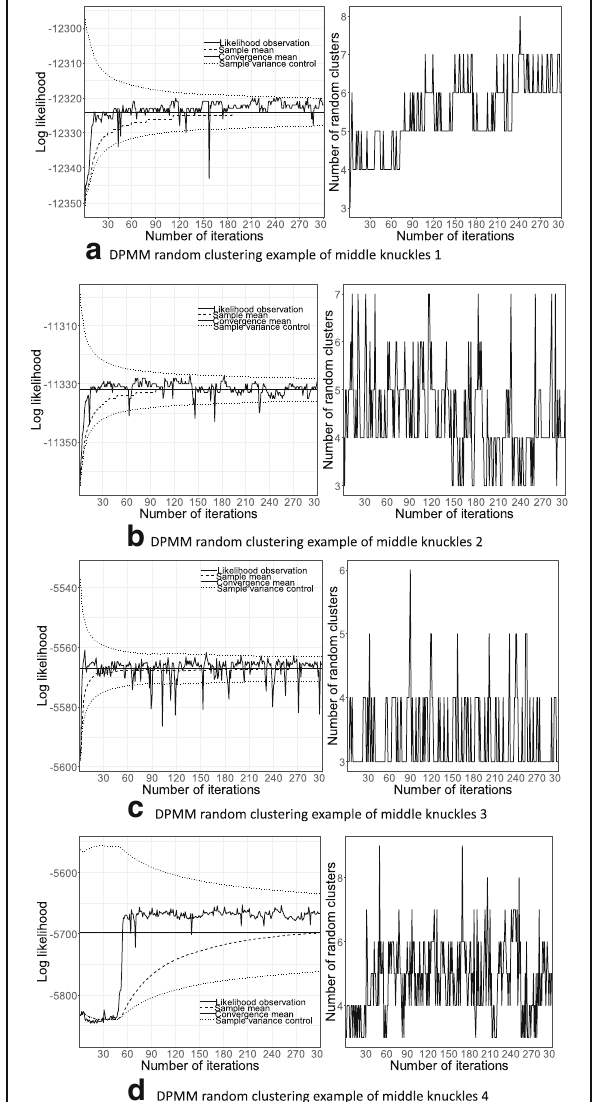
Fig. 4 Convergence of DPMM random cluster of far knuckles. a DPMM random clustering example far knuckles 1. b DPMM random clustering example far knuckles 2. c DPMM random clustering example far knuckles 3. d DPMM random clustering example far knuckles 4